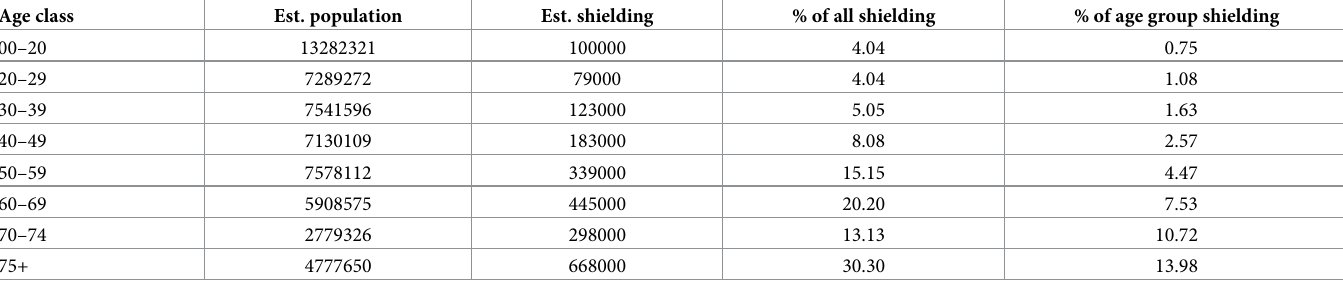
Table 3. Estimated age cohort populations and numbers shielding from ONS data [52, 54], estimated age distribution of shielding population, and proportion of each age group shielding. Age class Est. population Est. shielding % of all shielding % of age group